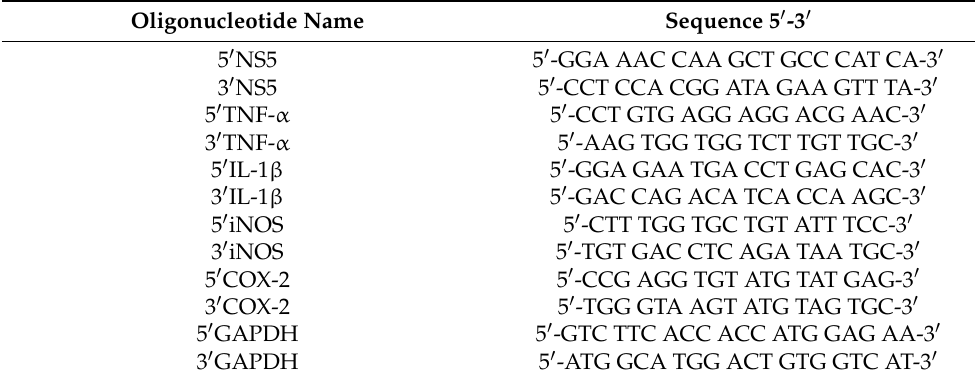
Table 1. Oligonucleotide sequences for real-time RT-PCR. Oligonucleotide